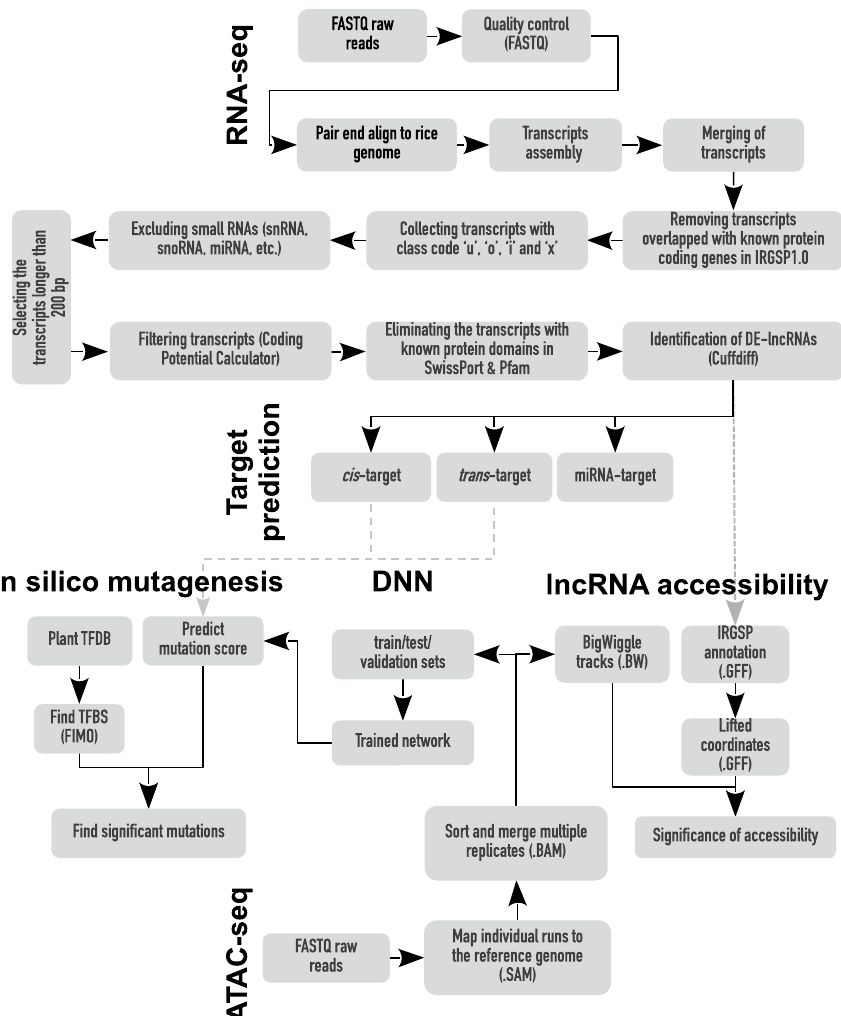
Figure 1. The integrated analysis pipeline for identifying the salt-responsive lncRNA in